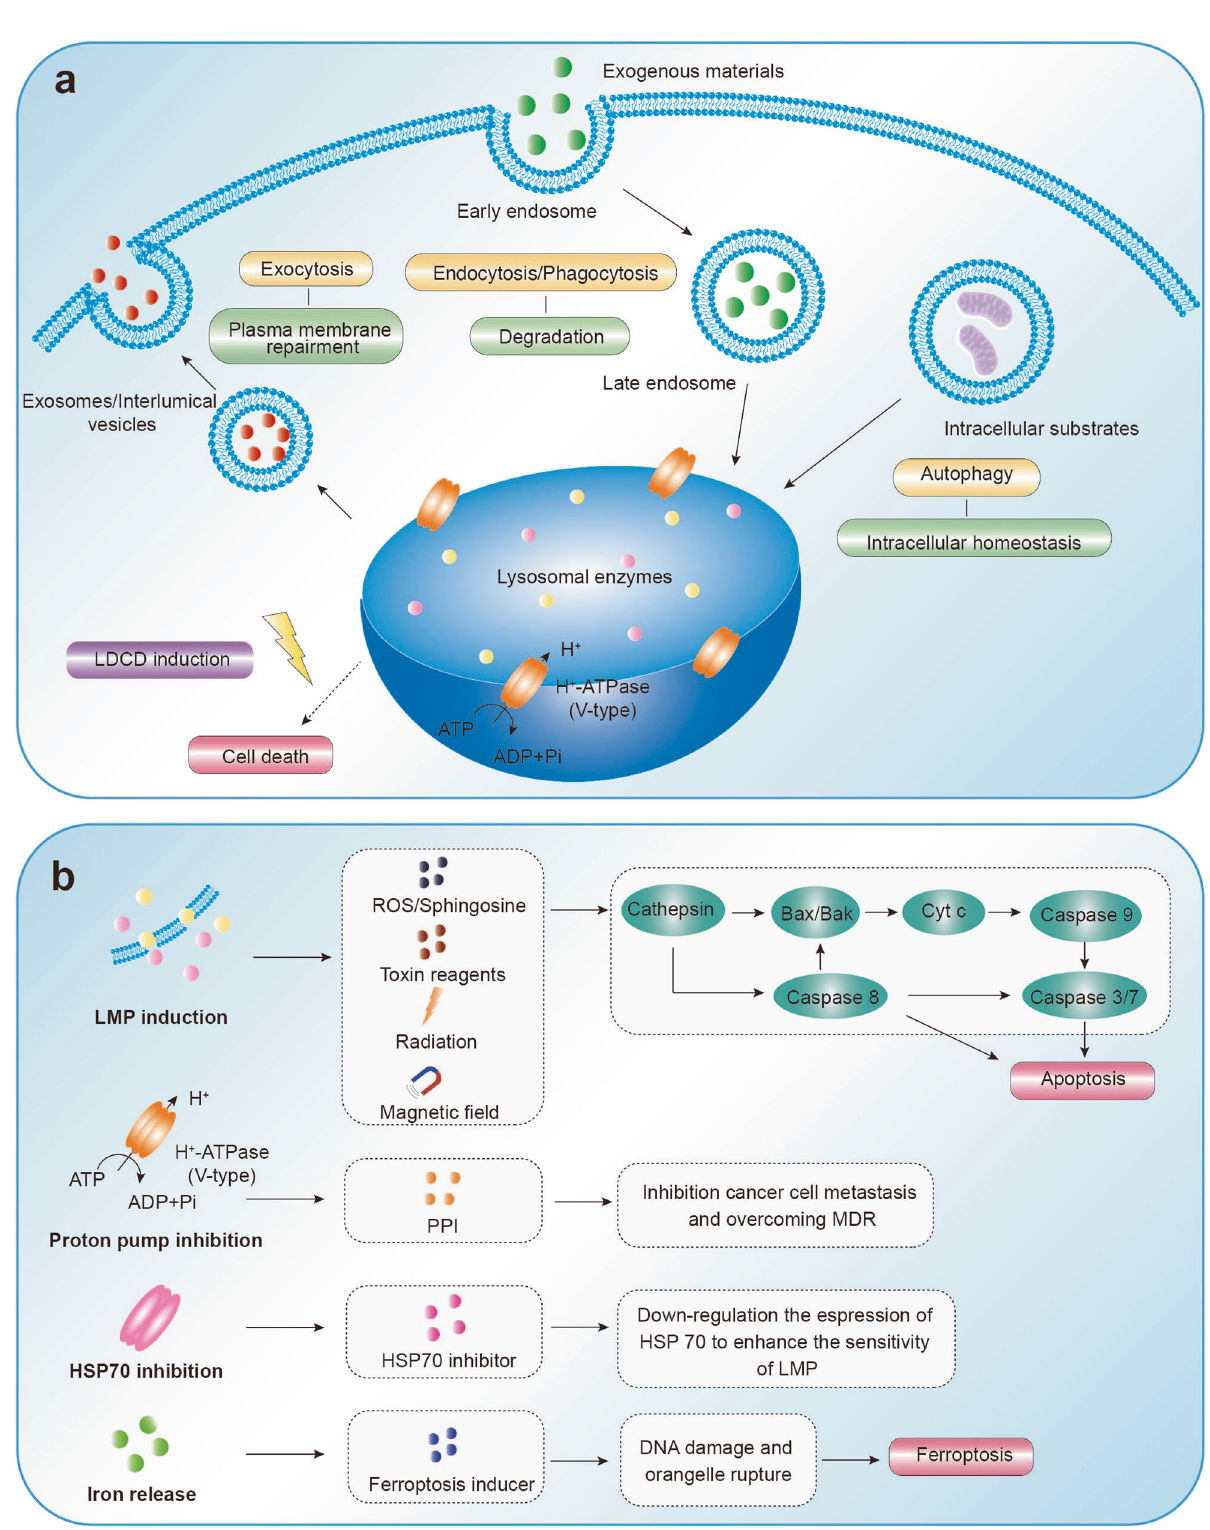
Fig. 5 The personalized therapeutic strategy toward lysosomes. a Lysosomes play a vital role in exocytosis, endocytosis, autophagy, and cell death. b LMP induction, as a typical approach, can be triggered by ROS, toxin reagents, radiation, and magnetic fi elds, eventually leading to caspase-dependent cell death. Proton pump inhibition is another strategy that enables overcoming MDR. Furthermore, HSP70 inhibition and iron release increase sensitivity to lysosomal-dependent cell death (LDCD). LMP lysosomal membrane permeabilization, ROS reactive oxygen species, Cyt C cytochrome c, PPI proton pump inhibitors, HSP 70 heat shock protein 70